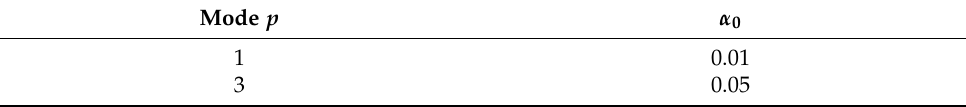
Table 2. Variation of α .